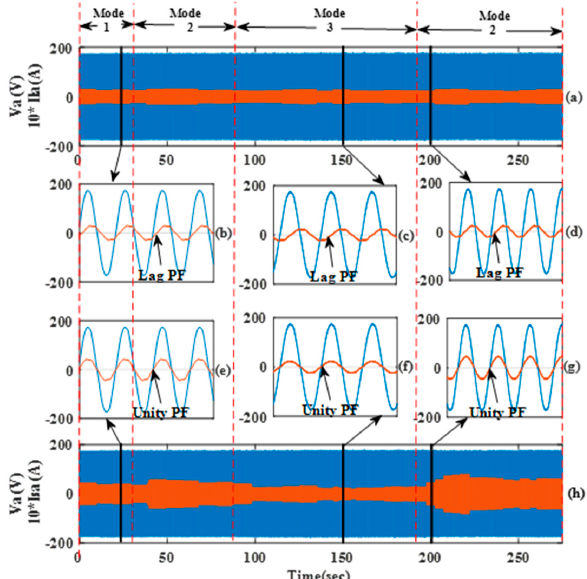
Figure 11. Experimental results showing the power factor correction effect on Phase A voltage and Phase A current: ( a ) Phase A Voltage (V) and load current, ( b ) zoom in between 25.03 and 25.1 s, ( c ) zoom in between 150.03 and 150.1 s, ( d ) zoom in between 200.03 and 200.1 s, ( e ) zoom in for between 25.03 and 25.1 sec, ( f ) zoom in between 150.03 and 150.1 s, ( g ) zoom in between 200.03 and 200.1 s, and ( h ) Phase A voltage (V) and Phase A supply current.